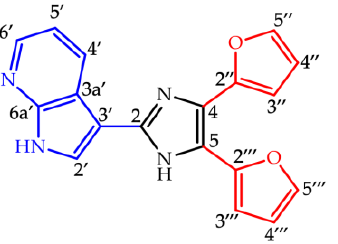
Figure 1. Structure of imidazole derivative 3 .